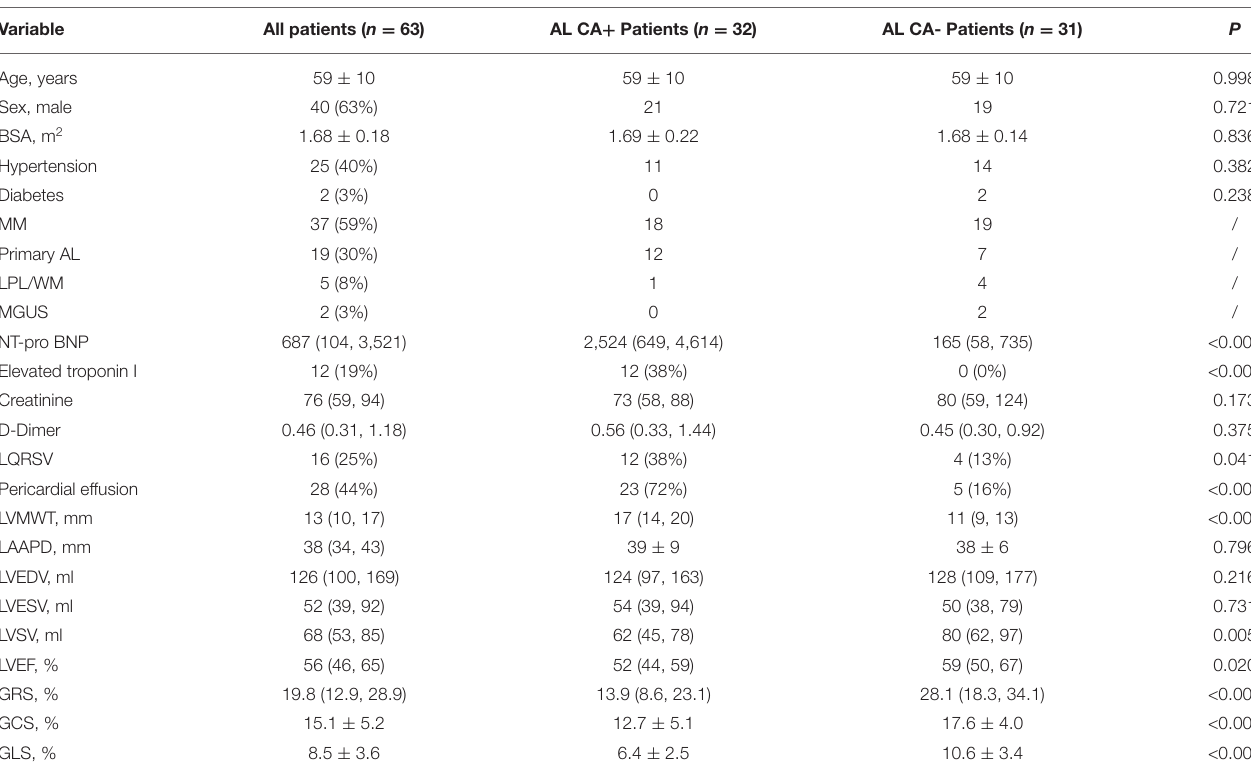
TABLE 1 | Baseline characteristics of patients at risk of AL CA. Variable All patients ( n = 63) AL CA + Patients ( n = 32) AL CA- Patients ( n = 31)